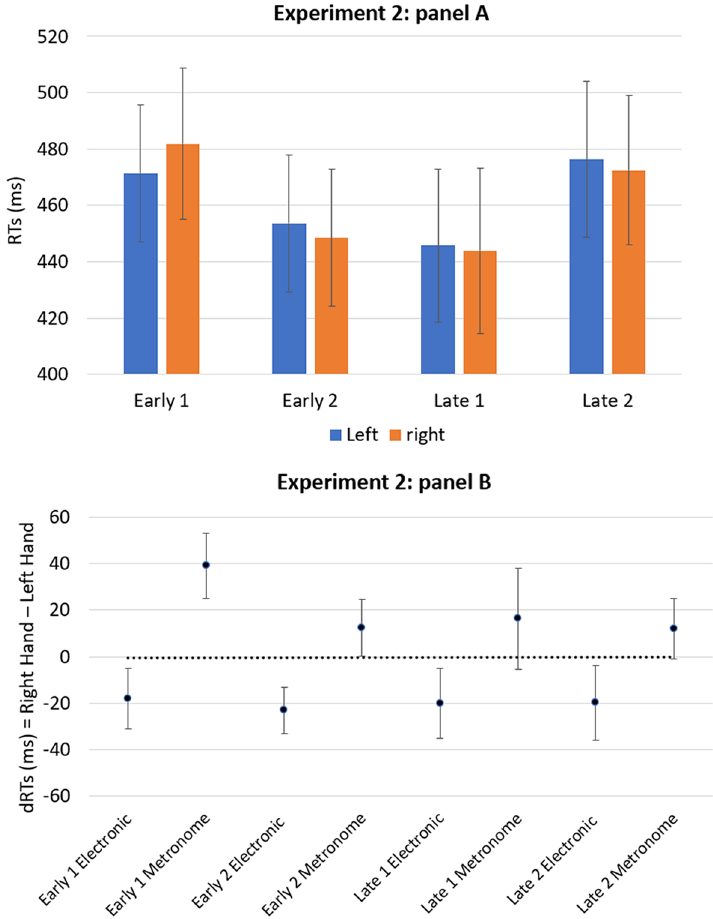
Figure 2. The panel ( A ) shows the mean of response times of the left and right hands for the four onset timing of the target (early 1, early 2, late 1, late 2). The panel ( B ) shows the mean dRTs (right key–left key) for each condition of the target. Positive differences indicate faster left-key responses; negative differences indicate faster right-key responses. Errors bars indicate standard error of the